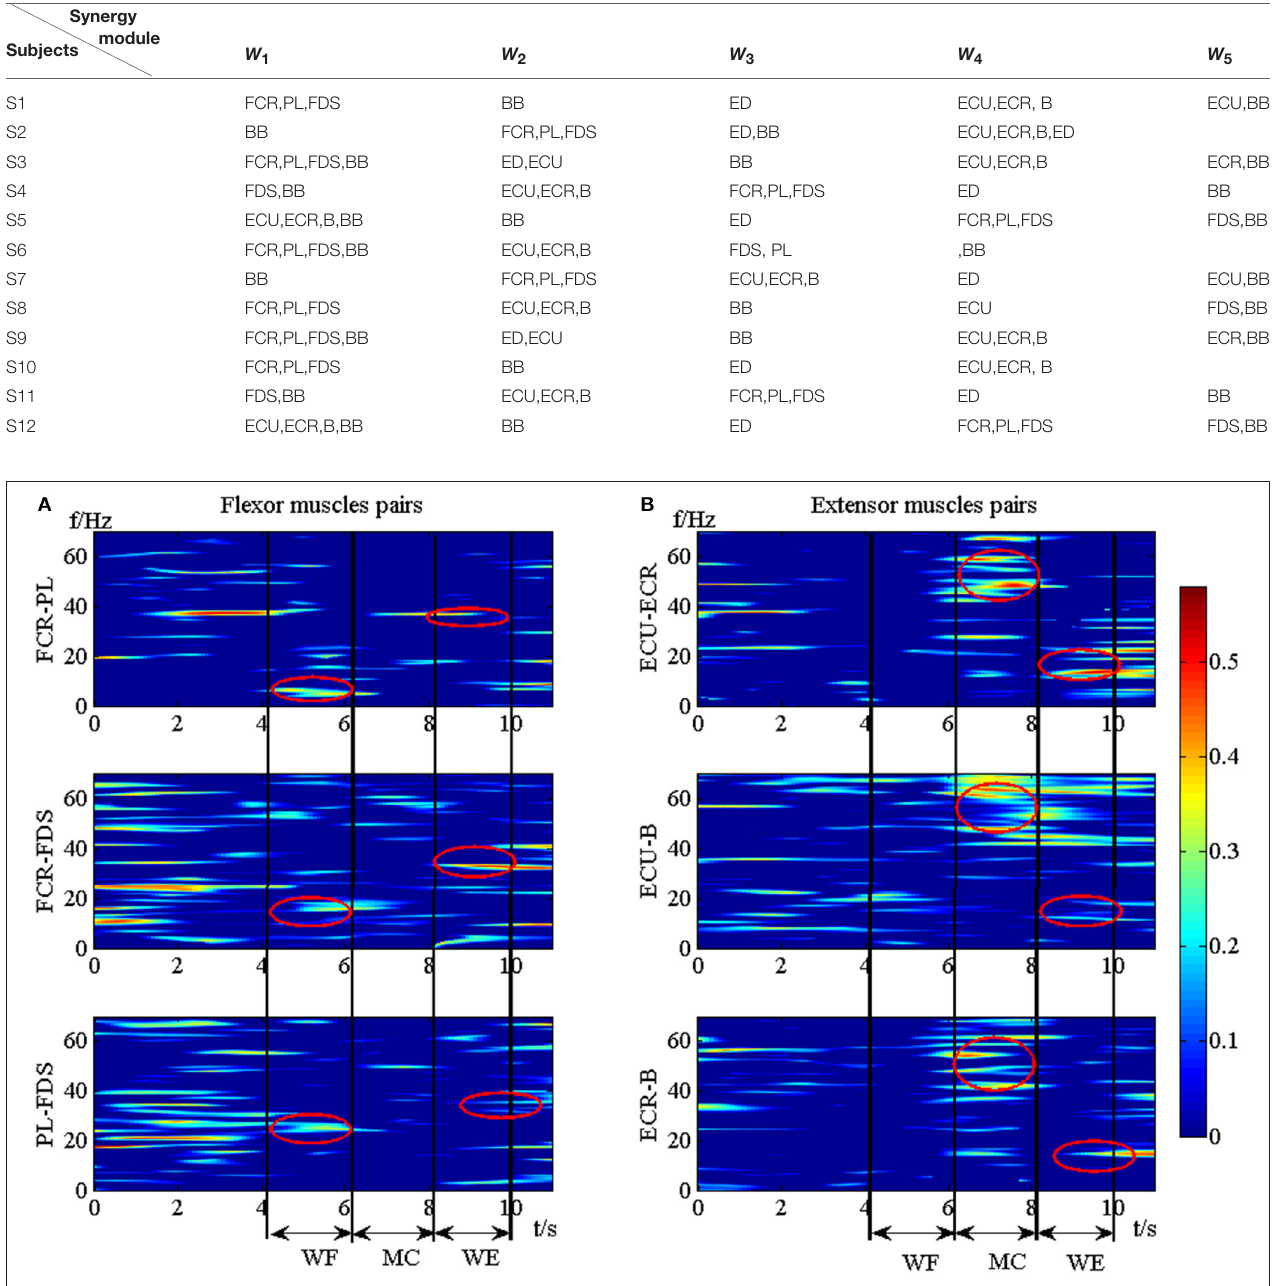
FIGURE 6 | The TFC values of the synergistic muscle pairs. (A) The TFC values for flexor muscle pairs. (B) The TFC values for extensor muscle